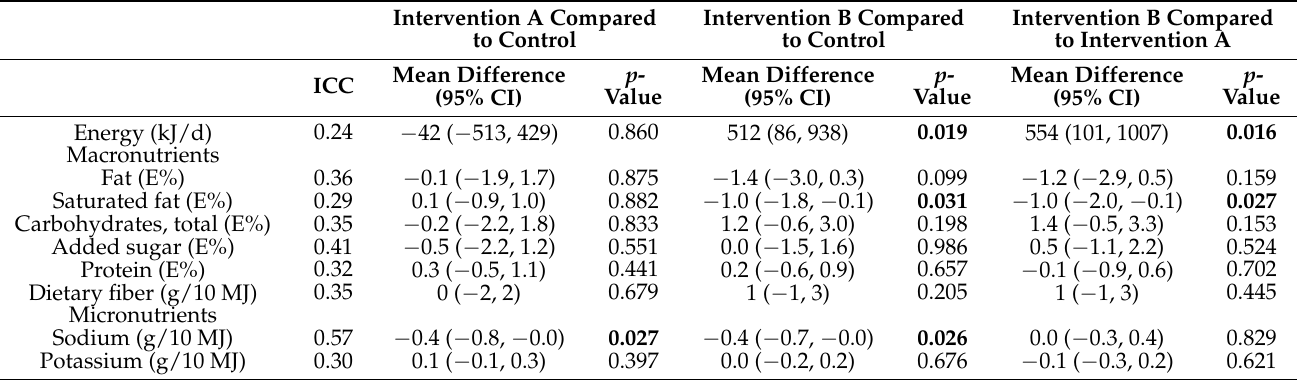
Table 6. Estimated differences between groups at follow-up in intake of energy and nutrients (g/10 MJ). Intervention A Compared Intervention B Compared Intervention B Compared to Control to Control to Intervention